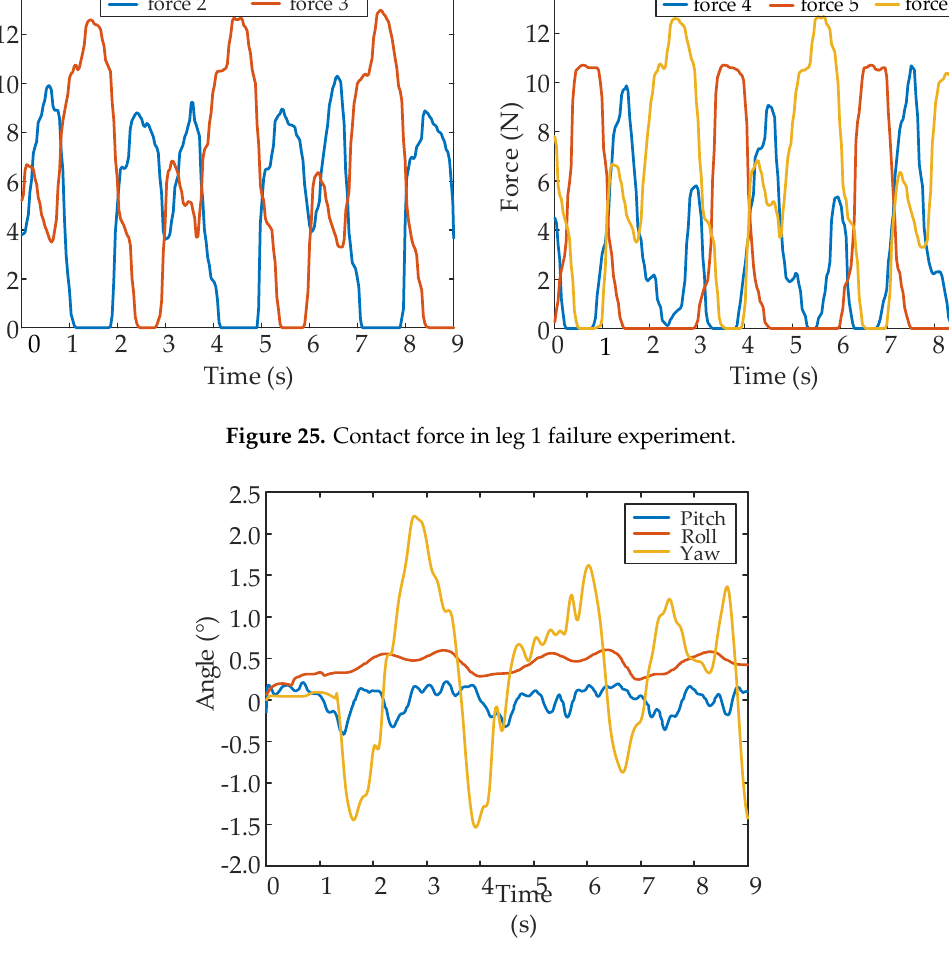
Figure 26. The pitch, roll and yaw angle of the center of gravity (COG) in leg 1 failure